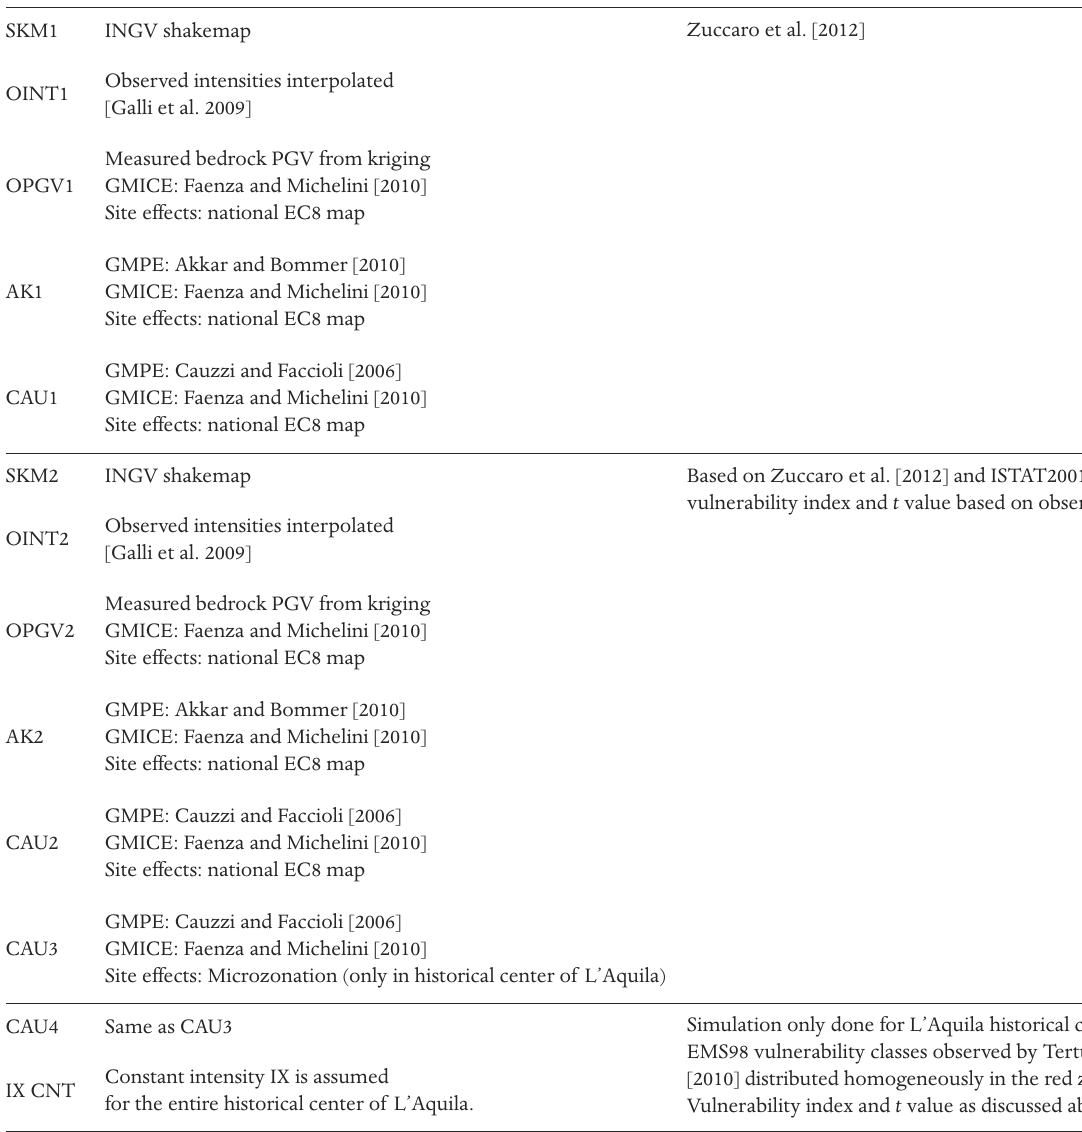
Table 3. Synthesis of the simulations considered in the present